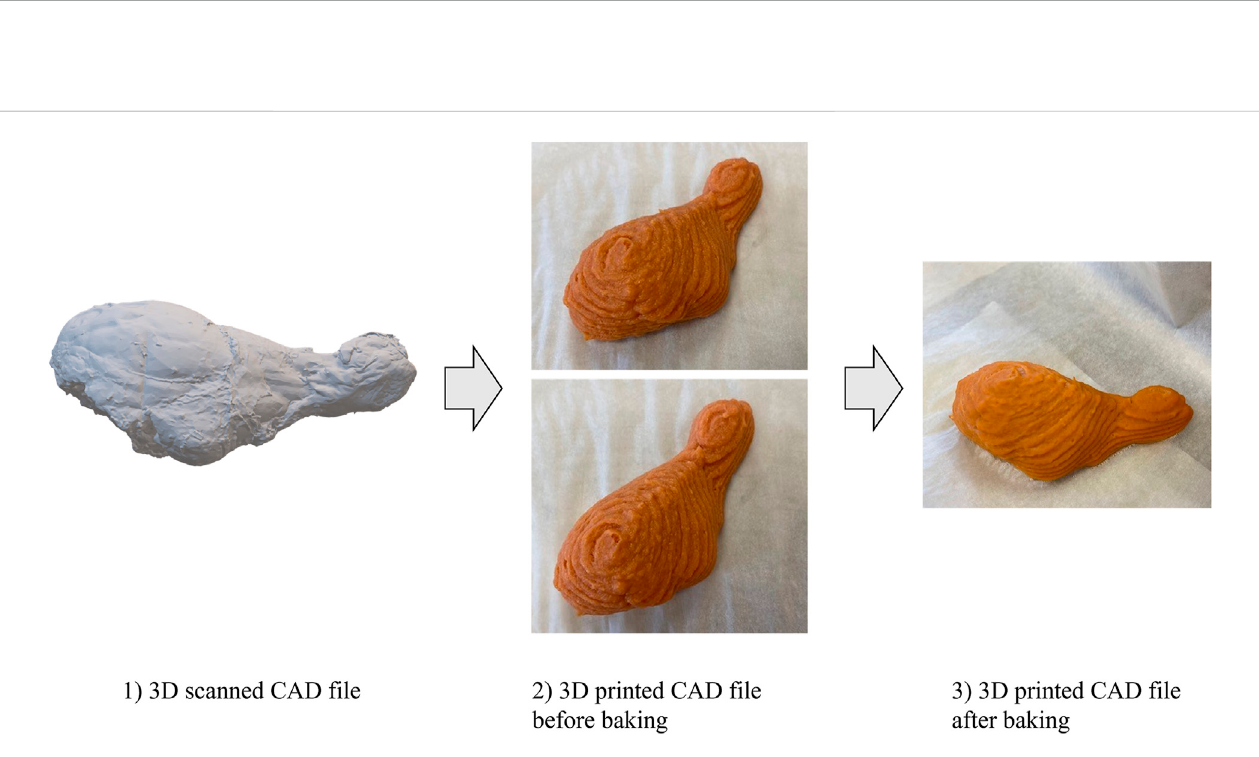
FIGURE 6 The CAD fi le of a 3D scanned chicken drumstick 1) before baking 2) and after baking 3). The dimension of the 3D printed drumstick was 4 cm × 10